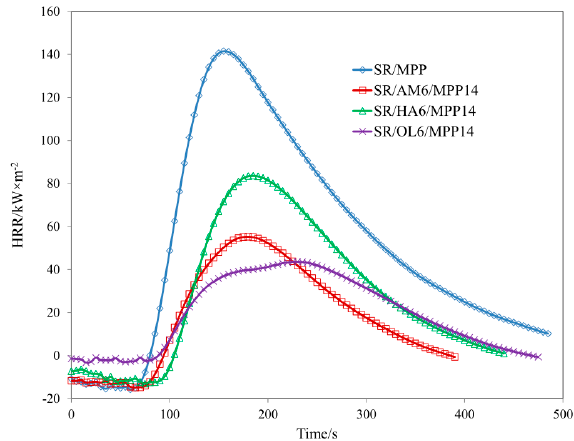
Figure 11. HRR curves composites of SR/POSS/MPP.